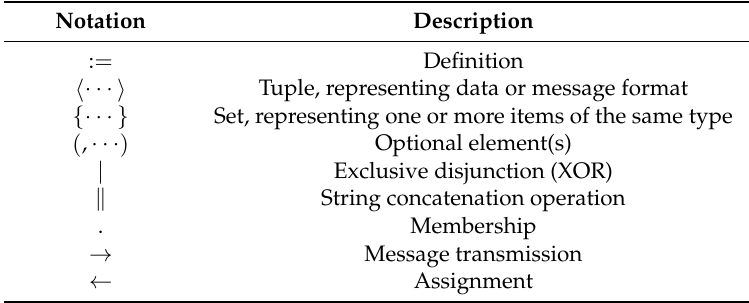
Table 1. Notations.